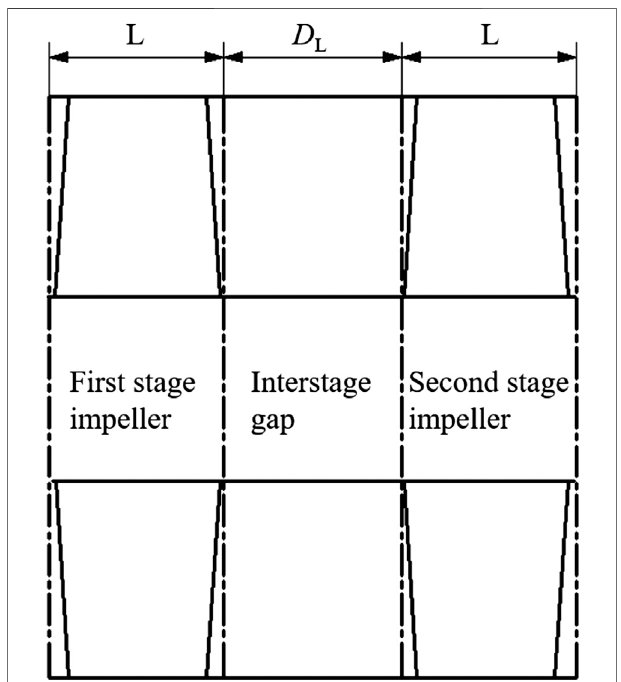
FIGURE 7 | Inter-level gap